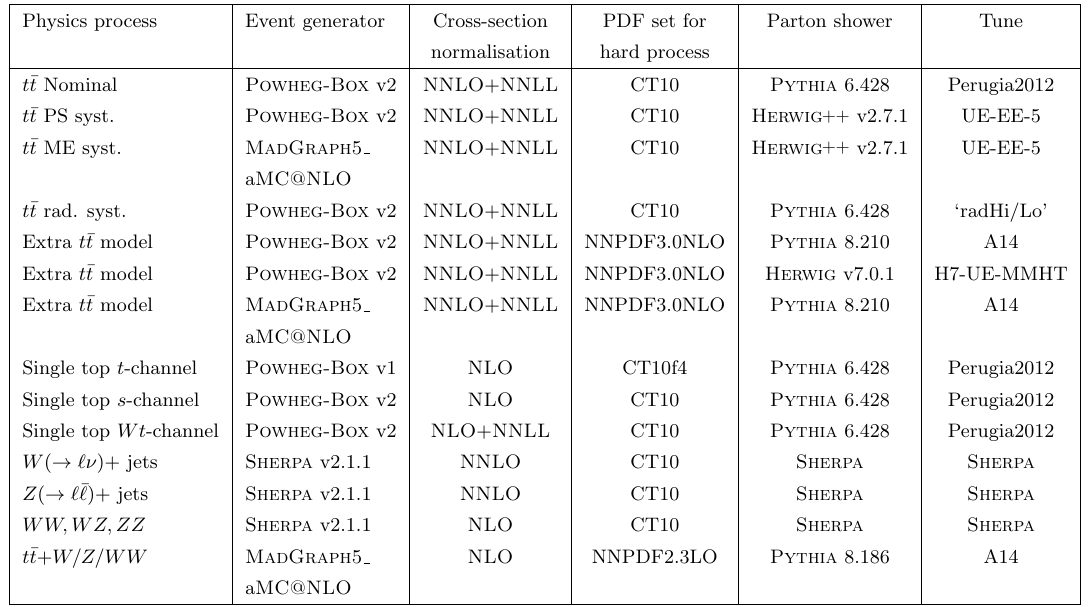
Summary of MC samples, showing the event generator for the hard-scattering process, cross-section normalisation precision, PDF choice as well as the parton shower and the corresponding tune used in the analysis. The Pythia6 and Herwig ++ parton-shower models use the CTEQ6L1 PDF set, while Pythia8 uses the NNPDF2.3LO PDF set and Herwig7 uses the MMHT2014lo68cl PDF